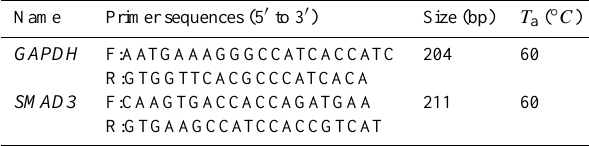
Table 1. Primers for quantitative